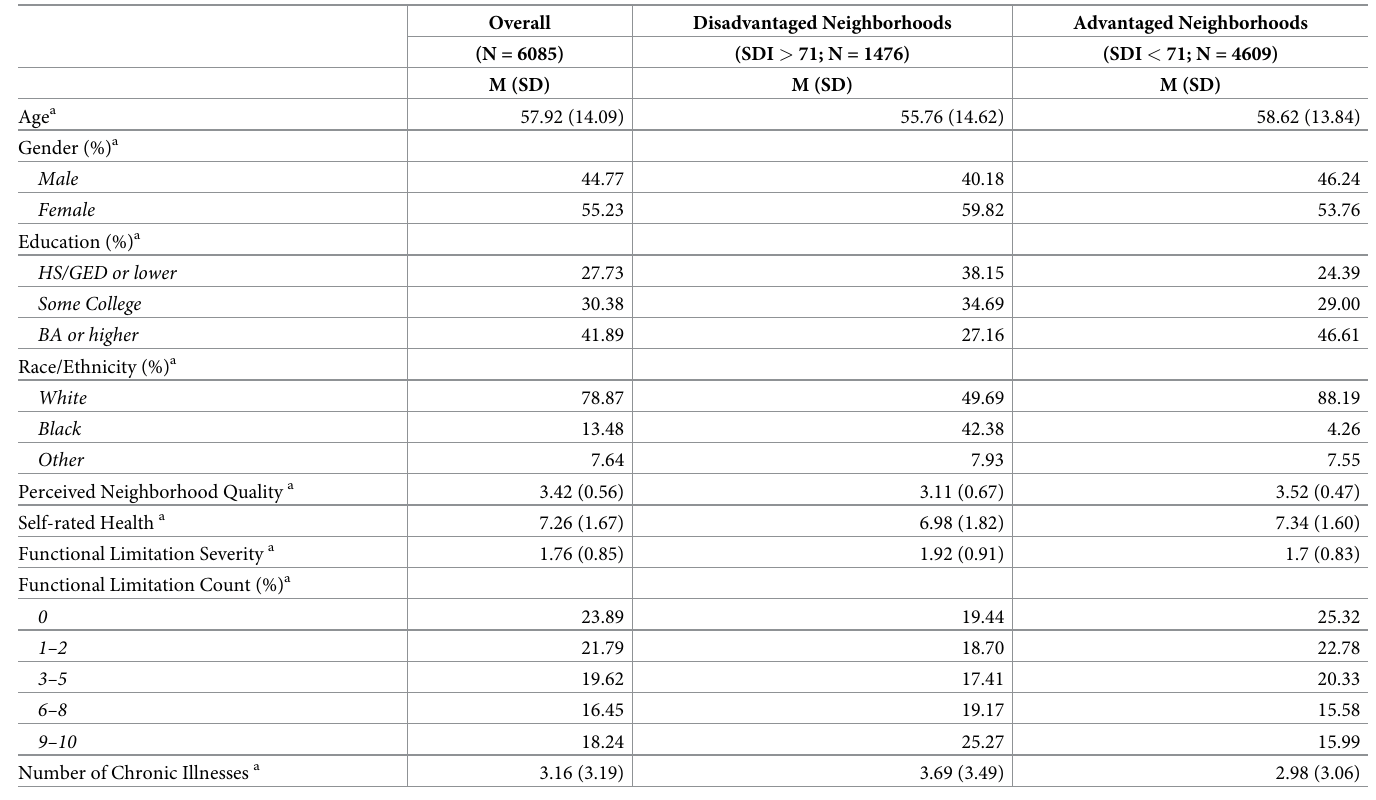
Table 1. Descriptive analysis of sample overall and by neighborhood